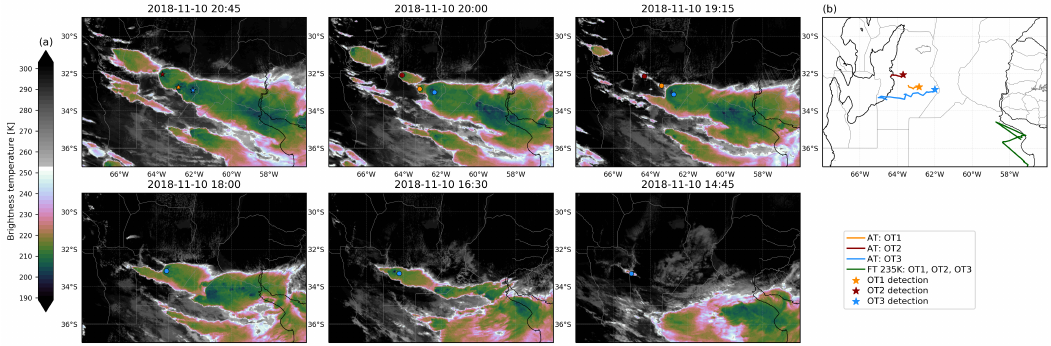
Figure 7. 10 November 2018: ( a ) GOES-16 TIR brightness temperature starting at Overshooting Tops (OTs, stars) detection time until estimated initiation time. Dots represents the tracking position for each OT associated convective system over time. ( b ) Tracking trajectories for AT (adaptive threshold) and FT (fixed threshold) techniques for the three OTs detected. 500 m height above sea level is added in black solid